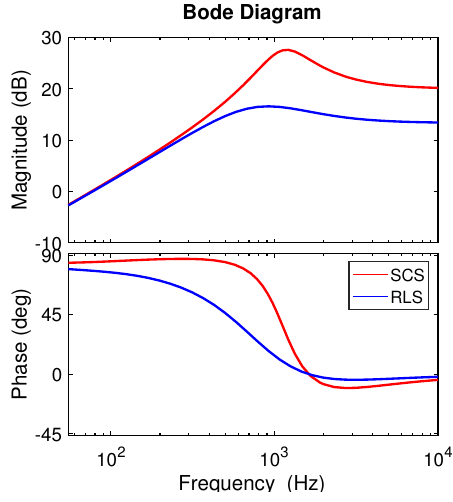
Figure 8. Bode diagram of the V PoC - h / I M 5- h